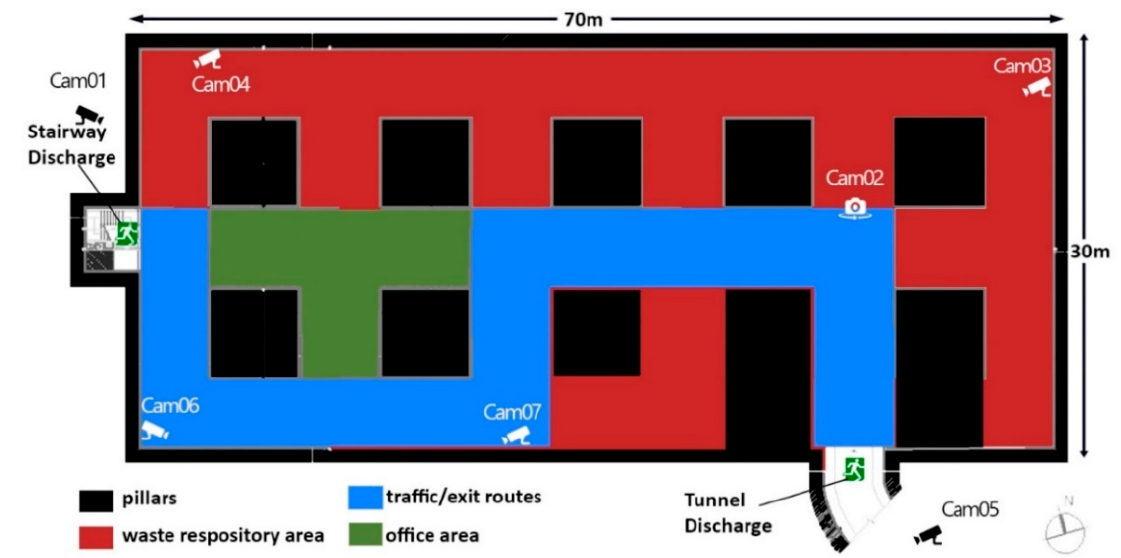
Figure 2. UHWR underground floor plan.